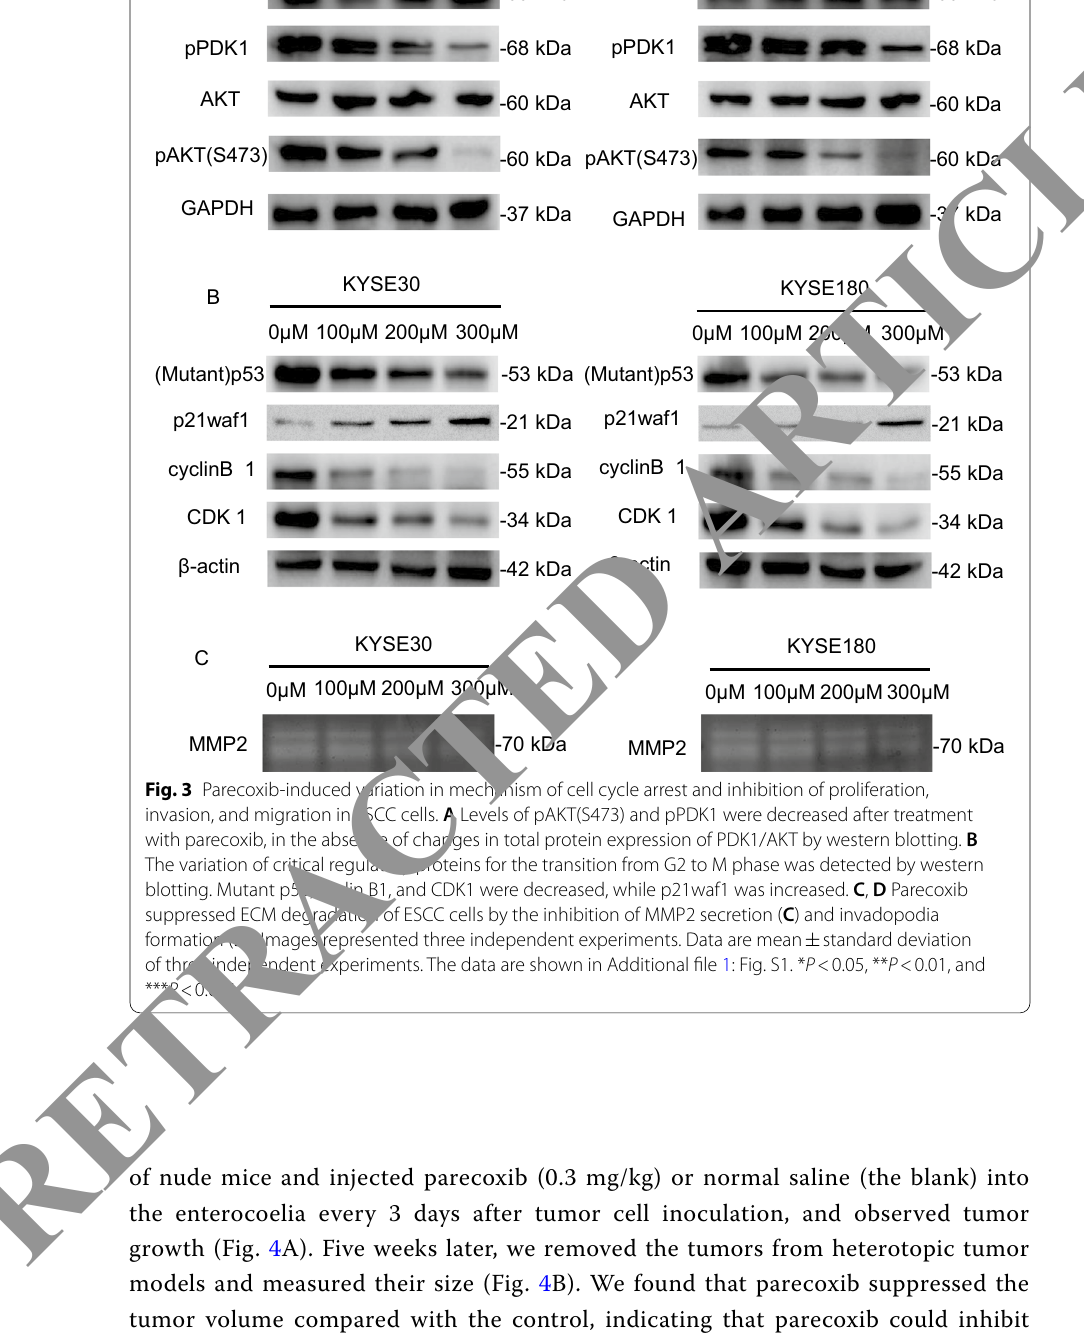
of nude mice and injected parecoxib (0.3 mg/kg) or normal saline (the blank) into the enterocoelia every 3 days after tumor cell inoculation, and observed tumor growth (Fig. 4A). Five weeks later, we removed the tumors from heterotopic tumor models and measured their size (Fig. 4B). We found that parecoxib suppressed the tumor volume compared with the control, indicating that parecoxib could inhibit ESCC growth in vivo.